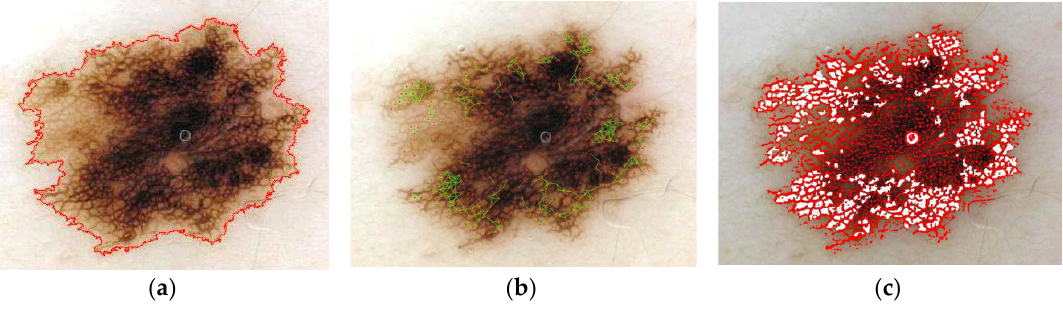
Figure 5. Detection of atypical pigmented network: ( a ) Lesion and superimposed contour; ( b ) result of the graph-based approach; ( c ) highlight of the atypical pigmented network (with high probability).